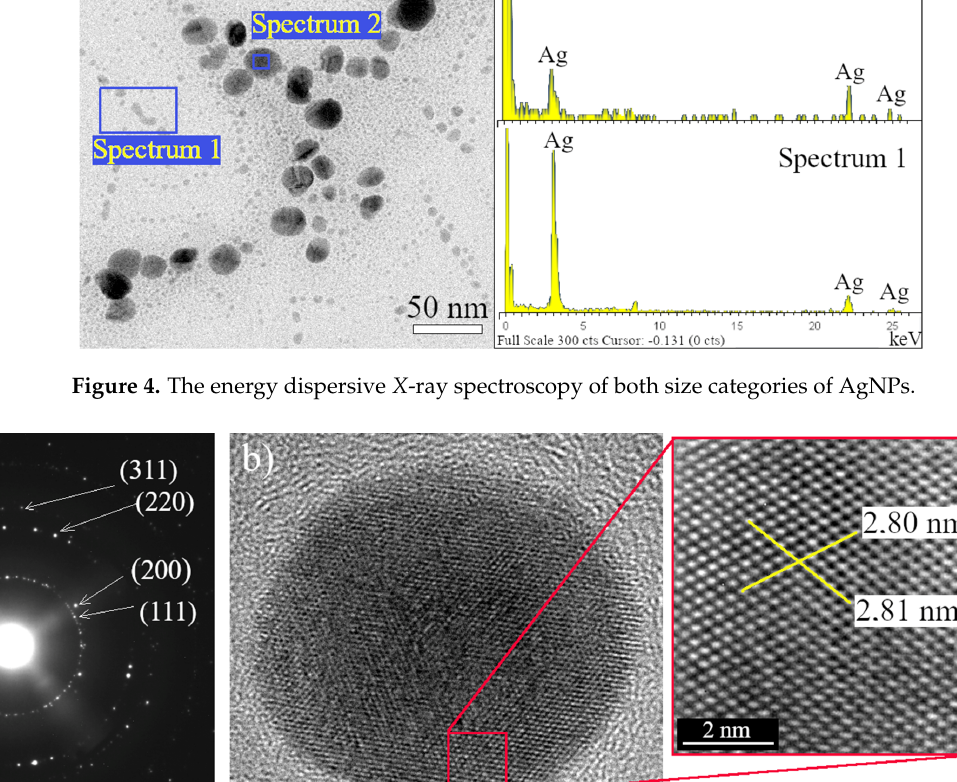
Figure 4. The energy dispersive X -ray spectroscopy of both size categories of AgNPs.